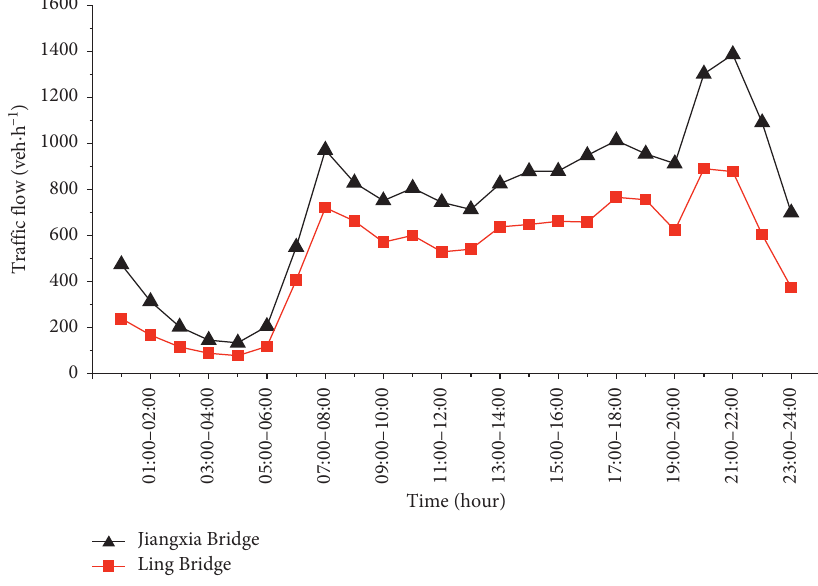
Figure 3: Daily average flow of the two restricted